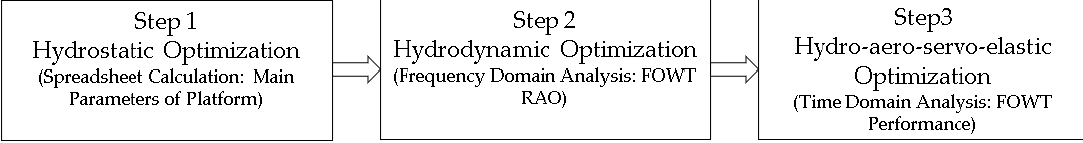
Figure 3. Design processes. Note: RAO = response amplitude operator.